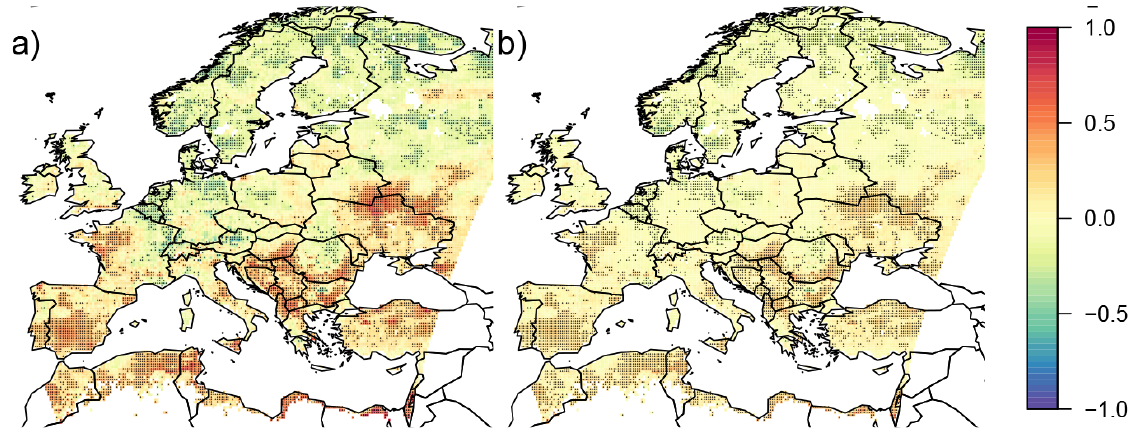
Figure 4. Ecosystem vulnerability (a) and risk (b) of carbon losses (negative NBP) to SPEI for the period 1981 to 2010. Reddish colours indicate high vulnerability to drought; significant cells are marked with black